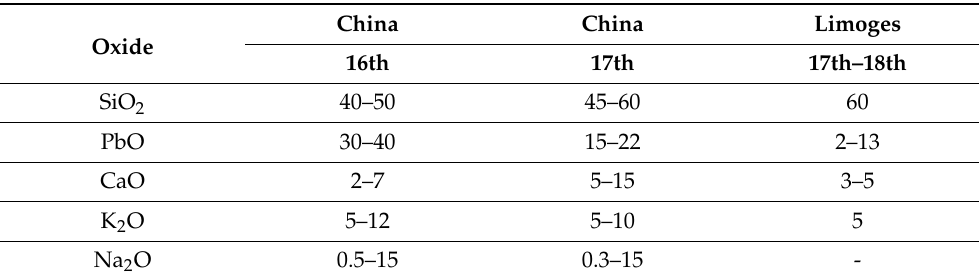
Table 3. Comparison of the composition range (oxide wt%) of Chinese cloisonn é and Limoges enamels (from Ref.